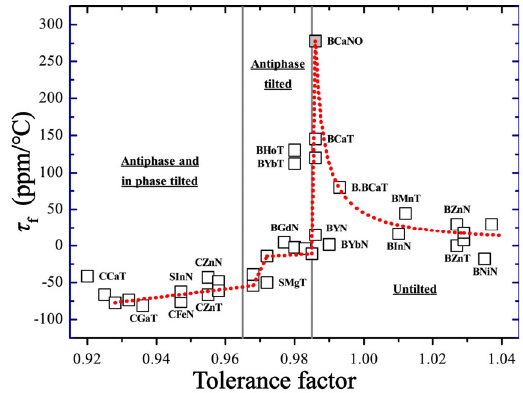
Fig. 24 Temperature coefficient of resonant frequency ( τ f ) versus tolerance factor ( t ) for A(B ′ ,B ′′ )O 3 (A = Ca, Sr, Ba; B ′ = Mg, Ca, Mn, Fe, Ni, Zn, Ga, In, Y, Gd, Tb, Dy, Ho, Er, Yb; B ′′ = Nb, Ta) 1:1 and 1:2 complex perovskites. Reproduced with permission from Ref. [524], © Elsevier Ltd and Techna Group S.r.l. 2016.